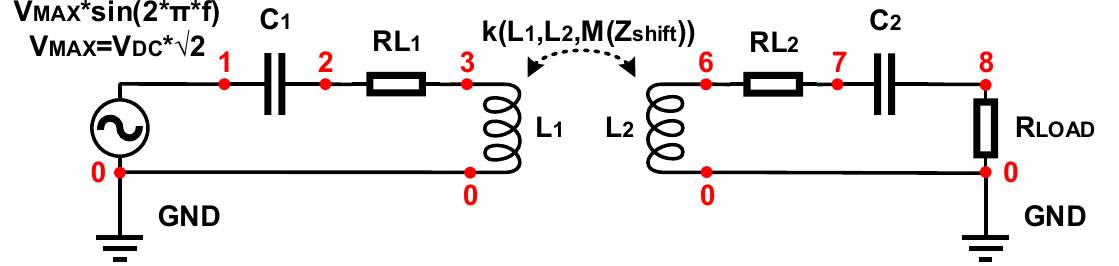
Figure 6. Electrical circuit definition within simulation model.